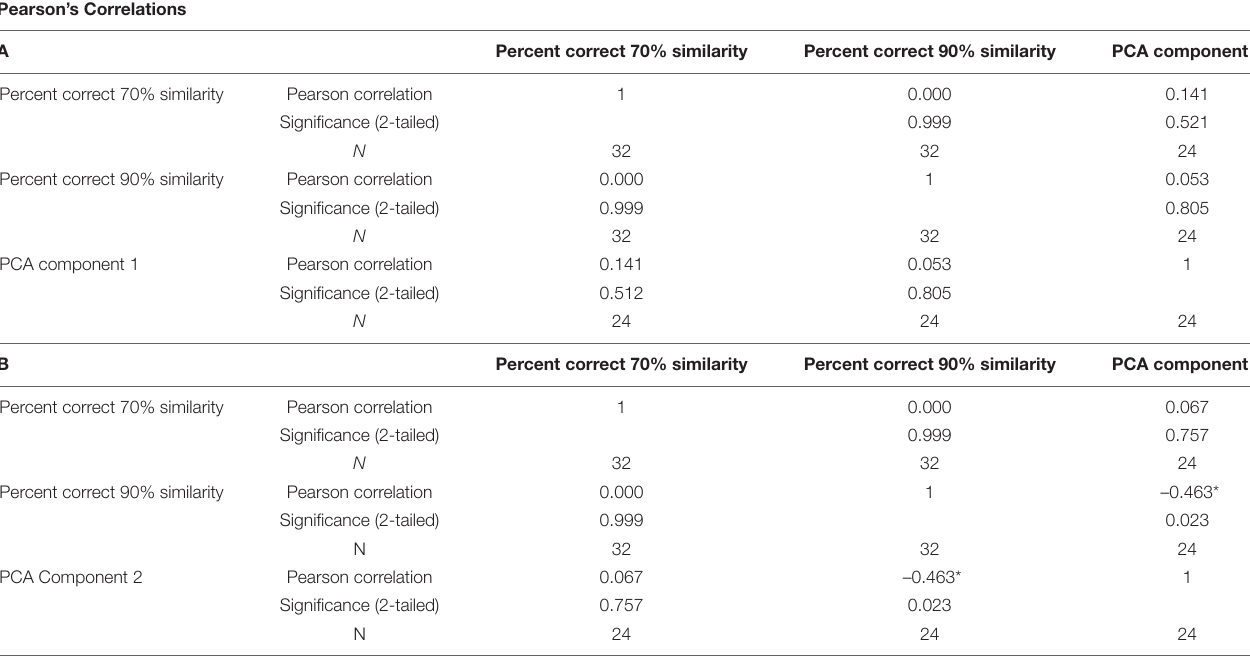
TABLE 2 | Pearson’s Correlations between percent of correct trials during 70 or 90% overlap conditions and either (A) the regression factor score for PCA Component 1 or (B) regression factor score for PCA Component 2. Pearson’s